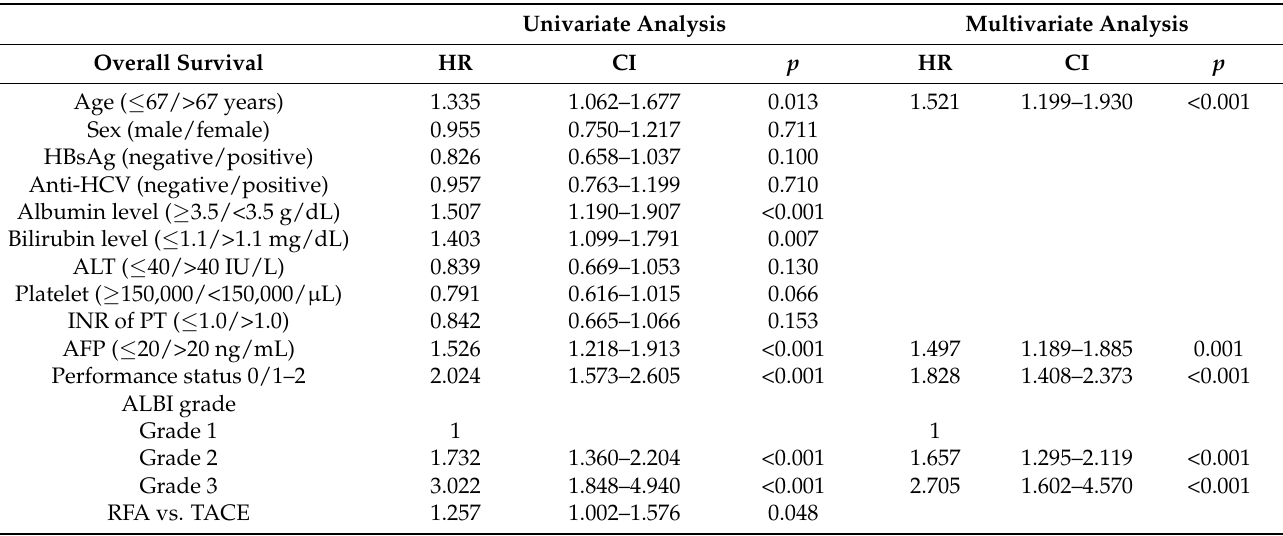
Table 4. Multivariate Cox analysis for RFA vs. TACE in HCC patients with medium tumor burden score (n = 413). Univariate Analysis Multivariate Analysis